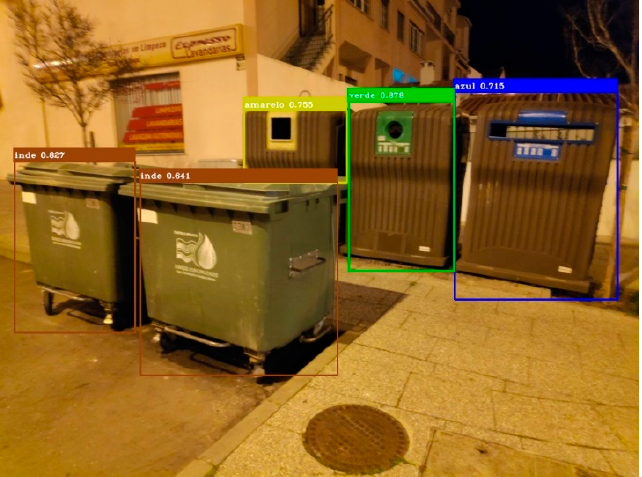
Figure 8. Correct detection with occlusion during night.